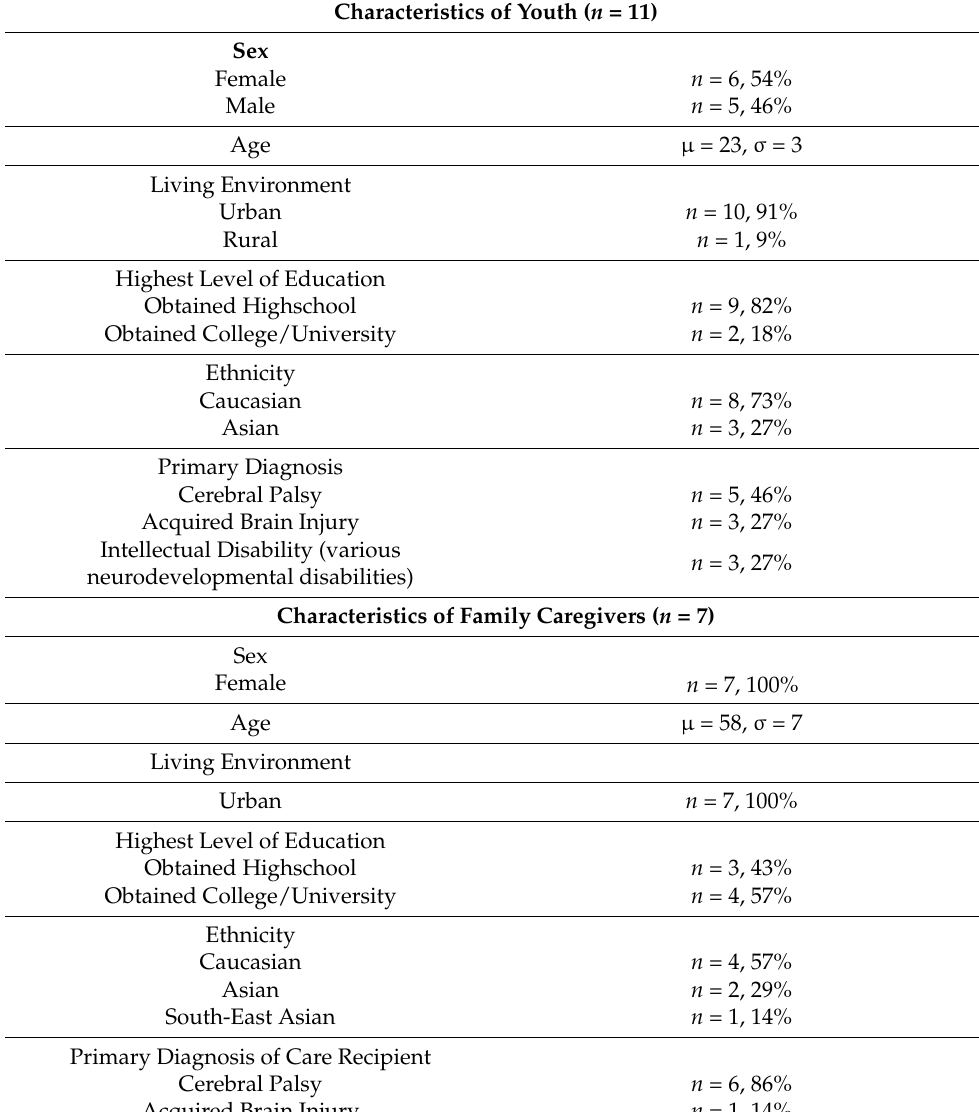
Table 3. Characteristics of